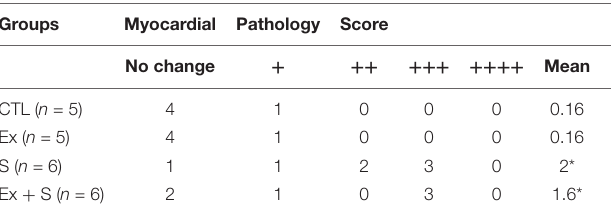
TABLE 1 | Histopathological scores and animal number with different degrees of injury in each group.